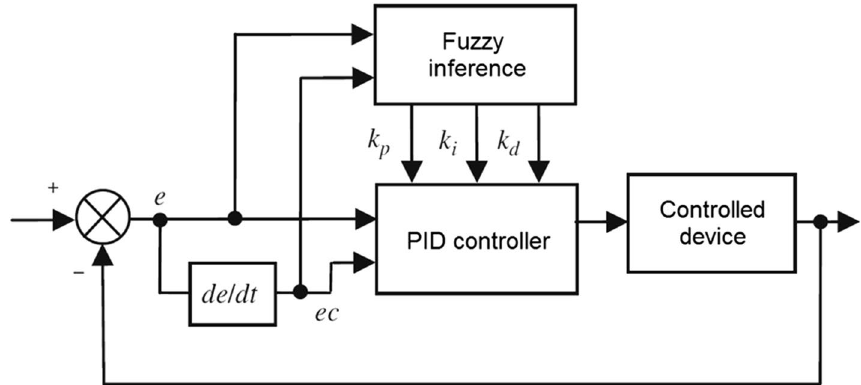
Fig. 7 Structure of fuzzy-like PID